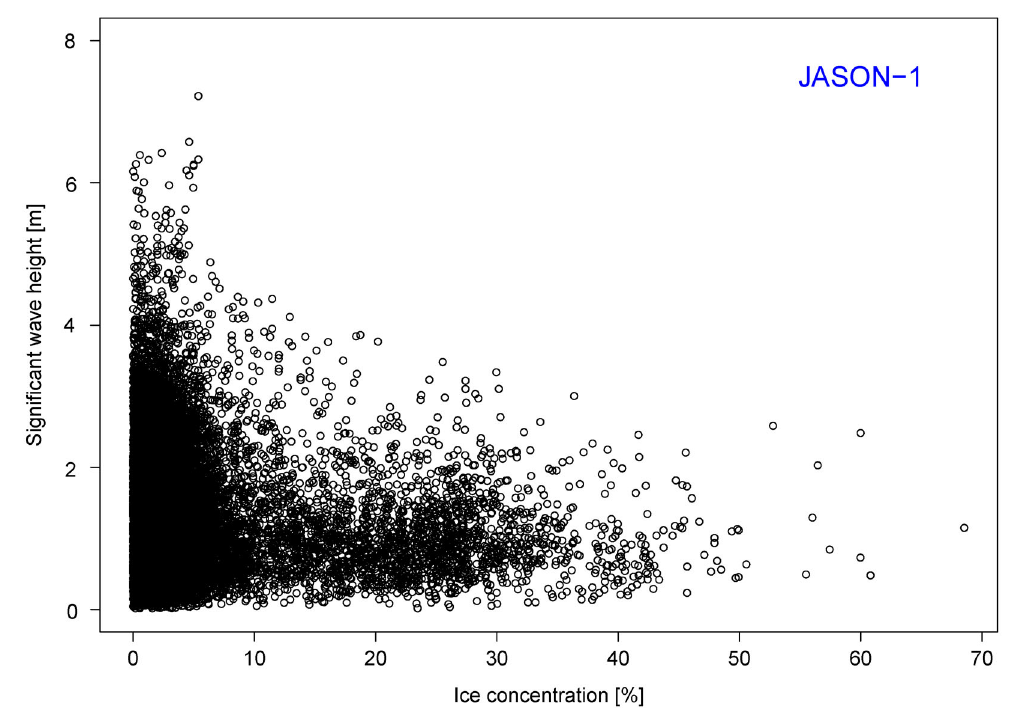
Fig. 7. JASON-1 significant wave height versus ice concentration in per